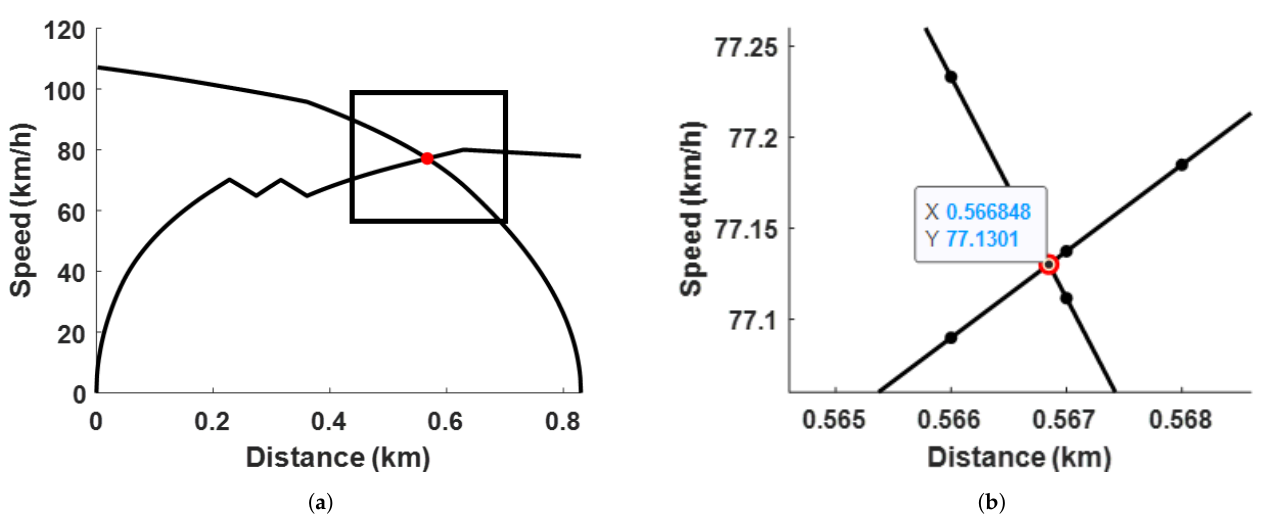
Figure 2. Breaking point decision by forward and backward moving calculation. ( a ) Breaking point decision—Forward and backward calculation yield intersection point. ( b ) Intersection calculation for breaking point determination—magnified figure for Figure